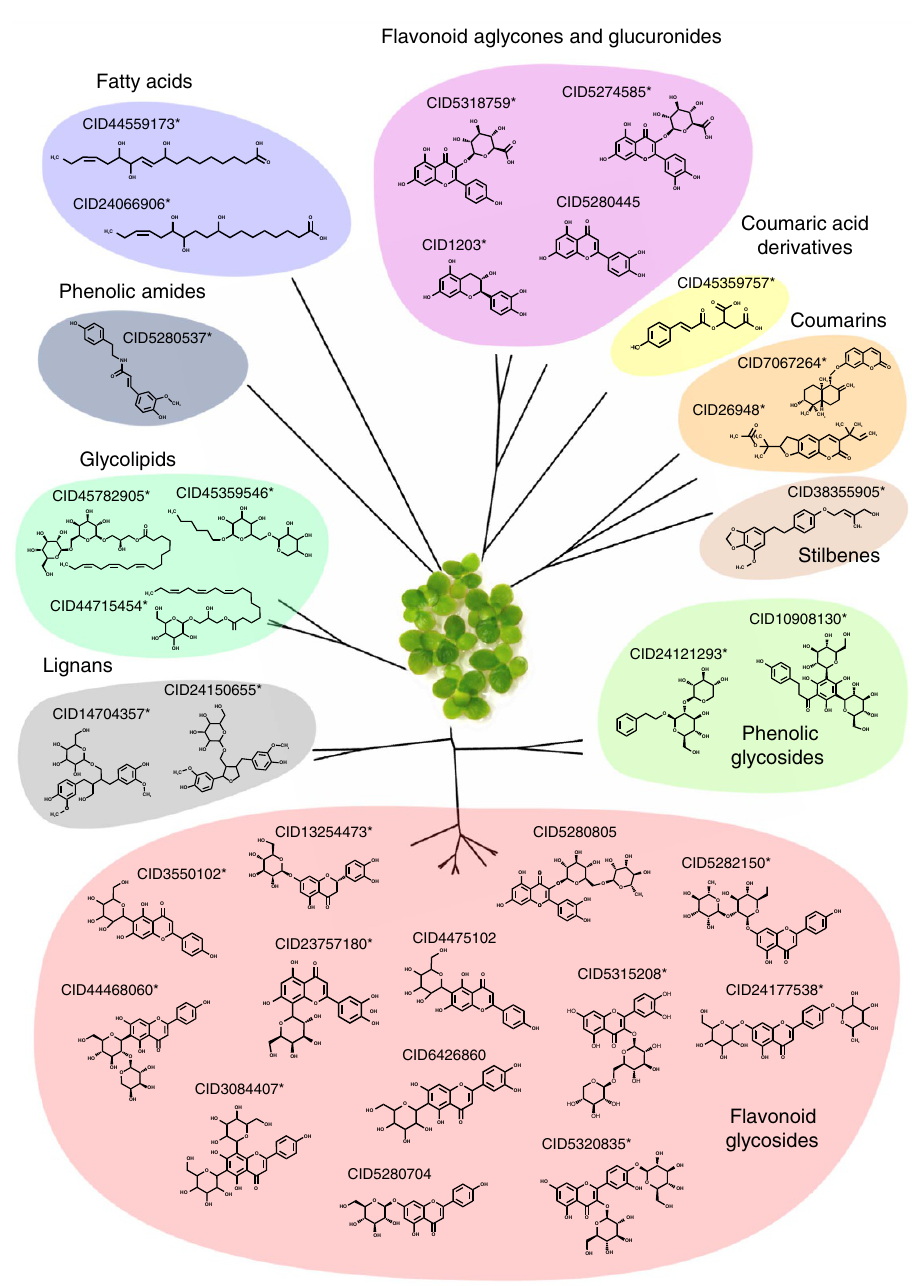
Figure 4 | Clustering by structural similarity of identified metabolites detected in members of the Lemnaceae family. The Tanimoto similarity index 26 was used to calculate the similarity between the identified metabolites based on their molecular fingerprints (1,024 bits, binary). Metabolites marked with asterisks are either ‘never published in that plant species’, or ‘never published or associated with any organism’ (Supplementary Data 1–4). PubChem CIDs corresponding with each metabolite are given next to the chemical structure. See also ‘Clustering of identified metabolites by structural similarity’ in the Methods